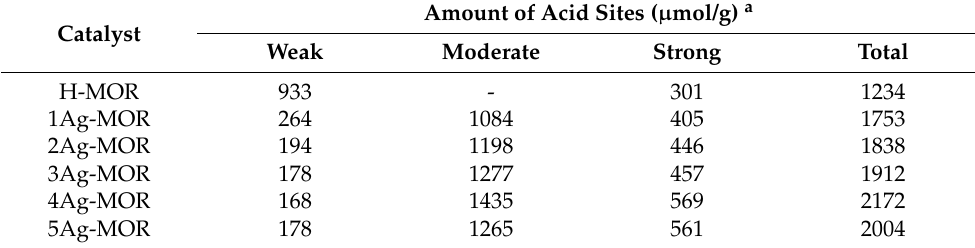
Figure 7. NH 3 ‐ TPD profiles of the catalysts. Figure 7. NH 3 -TPD profiles of the catalysts. Table 3. The amount of acid sites of Table 3. The amount of acid sites of catalysts.